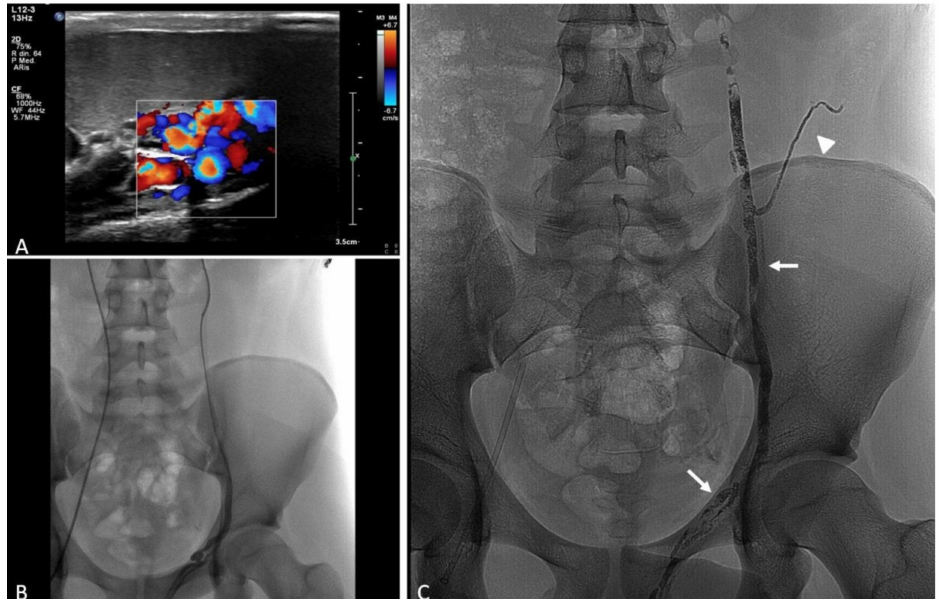
Figure 13. Transcatheter glue embolization of varicocele in a 17-year-old male. ( A ) Color Doppler US image shows enlarged vessels of the pampiniform plexus with flow reversal during the Valsalva maneuver. ( B ) Fluoroscopic image shows selective transfemoral catheterization of the left spermatic vein up to the iliac region above the inguinal canal. ( C ) X-rays image shows the glue/ethiodized oil cast completely filling the left spermatic vein. Note the duplicated spermatic veins (arrows) and the collateral vessel (arrowhead) also filled with the embolic